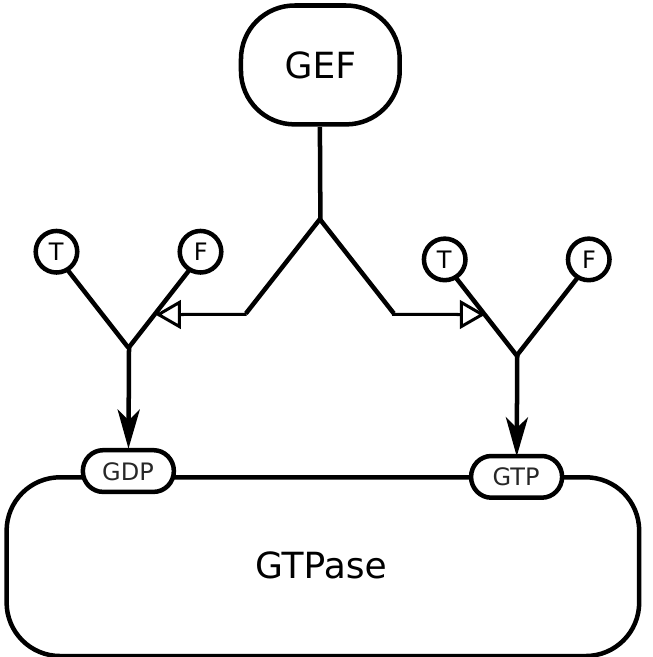
Figure 2.47: GTPase activation by